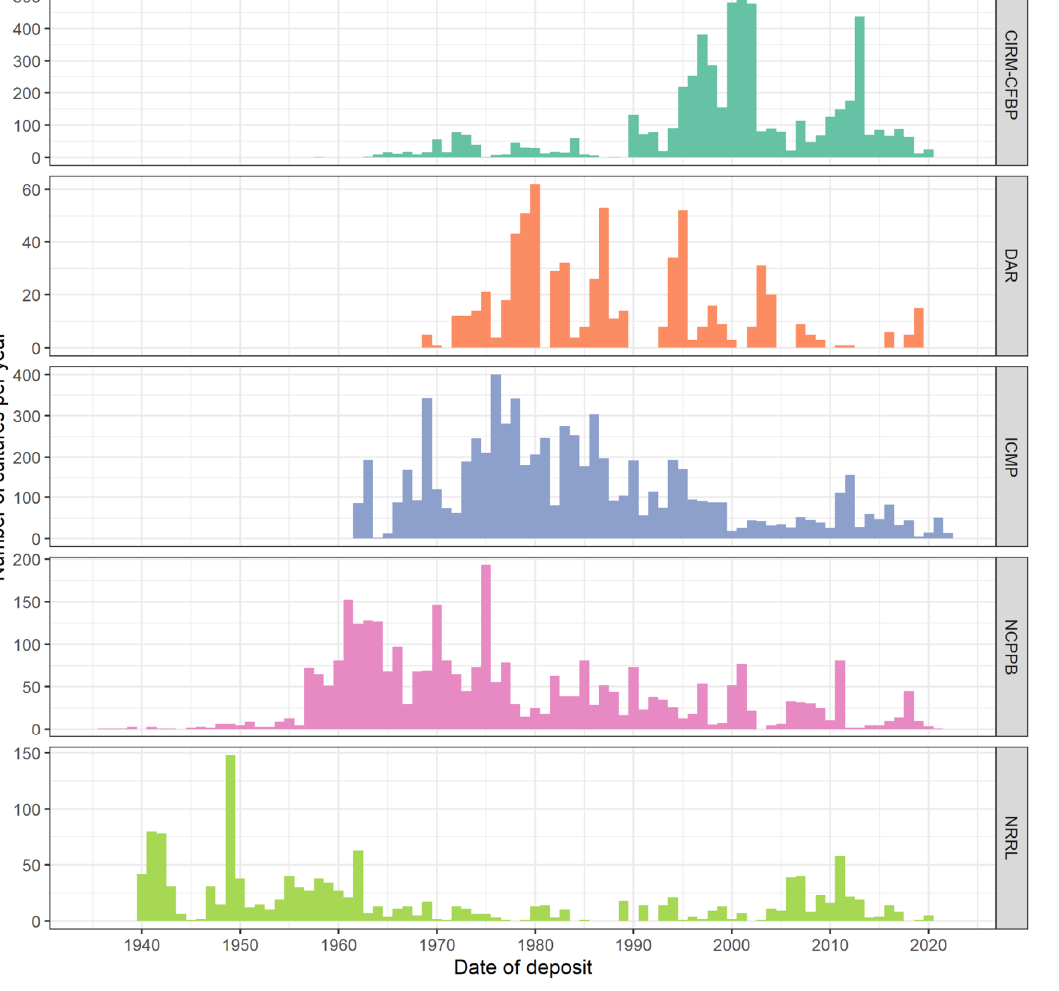
Figure 3. A histogram showing the dates of strain deposit in five global phytopathogen culture col- lections: CIRM-CFBP, DAR, ICMP, NCPPB, and NRRL. The collections have different establishment collections: CIRM-CFBP, DAR, ICMP, NCPPB, and NRRL. The collections have different